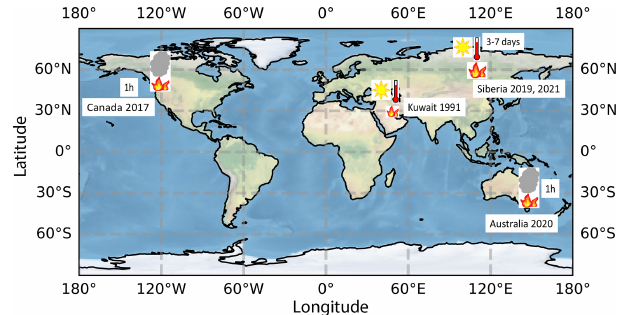
Figure 6. Map of the fire events discussed in this study. PyroCb- related smoke lofting (symbolized by a gray cloud above the fires) occurred over British Columbia, Canada, in August 2017 and over southeastern Australia in December 2019 and January 2020. It is as- sumed that self-lofting of wildfire smoke (symbolized by a sun and a thermometer over the fires) occurred over Siberia and the outflow regime (i.e., mainly over the Arctic region north of 60–70 ◦ N) in July and August 2019. Similarly, we assumed self-lofting over the oil-burning smoke areas in Kuwait in March 1991. Smoke reaches the tropopause within a short time period (of the order of 1h) in the case of pyroCb convection and may reach the tropopause after several days (3–7d) in the case of